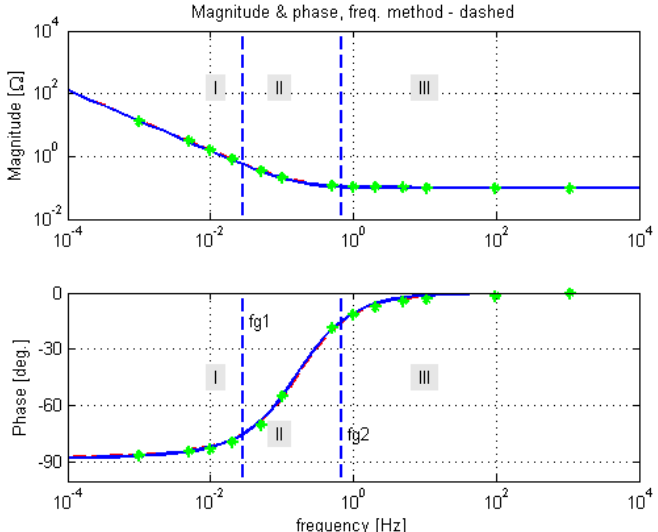
Figure 13. Results of SC 10 F impedance identification by two methods. The measured frequency response points are marked with asterisks. Lines: marked as in Figure 10.